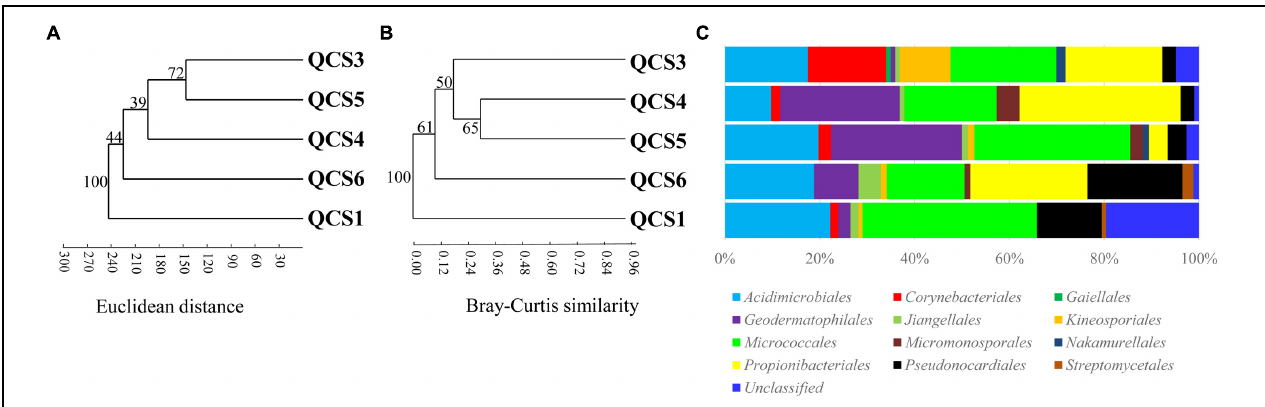
FIGURE 3 | (A) Cluster analysis of environmental variables in the studied samples based on Euclidean distance; (B) Cluster analysis of actinobacterial community composition in the studied samples based on Bray-Curtis similarity; (C) Schematic figures showing the frequencies of OTUs affiliated with major actinobacerial orders in this study.